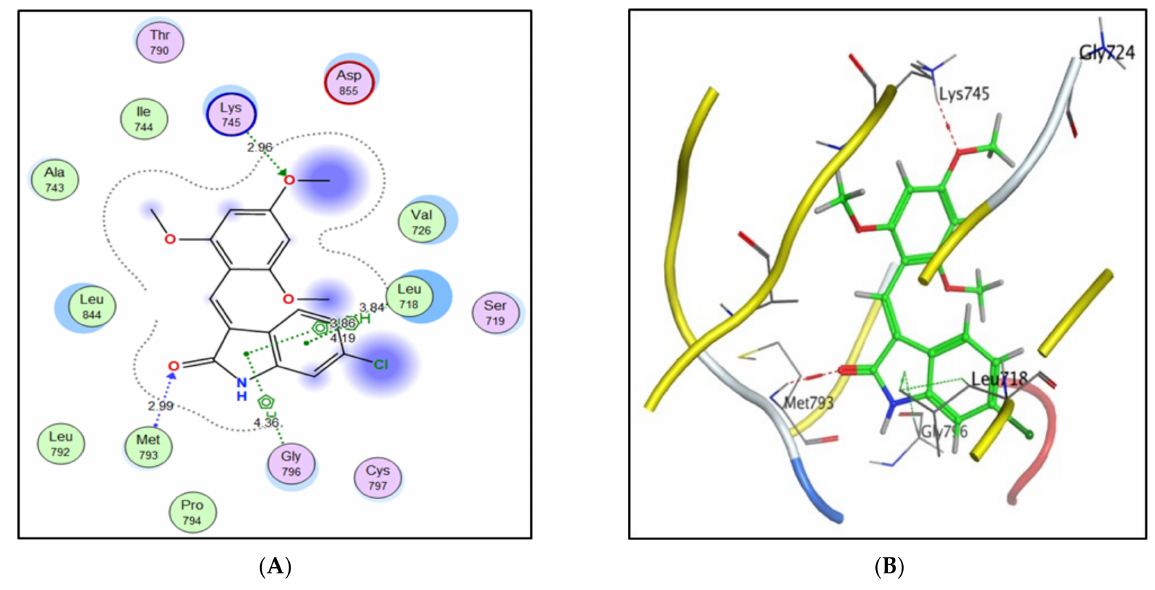
Figure 9. Two-dimensional diagram ( A ) and 3D representation ( B ) of compound 4b in the EGFR binding